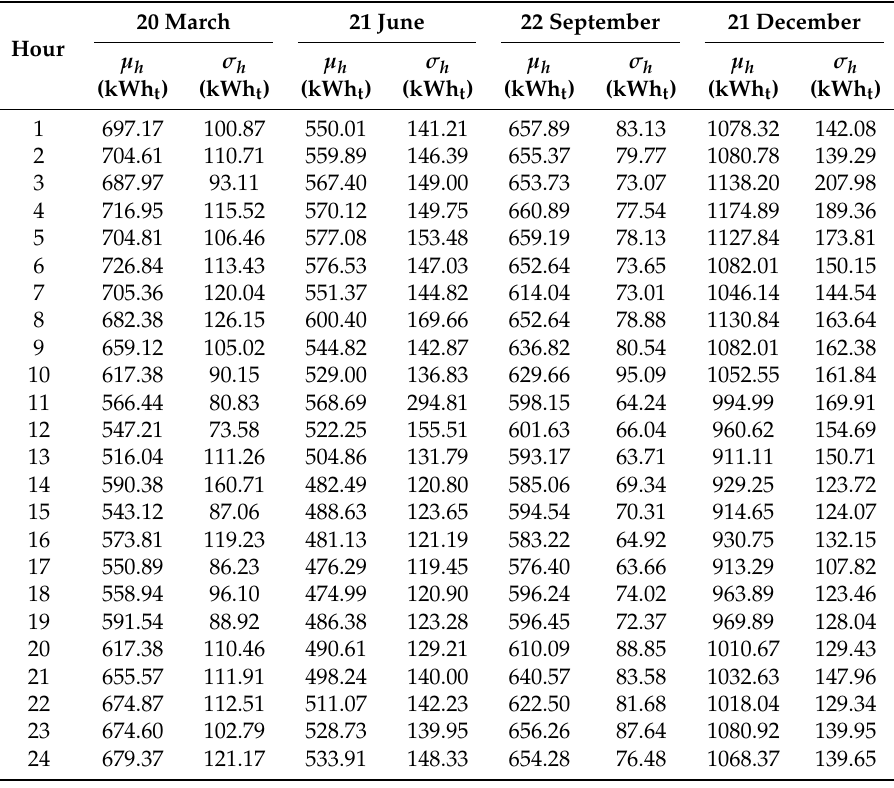
Table A2. Heating load parameters (mean and standard deviation) on four different